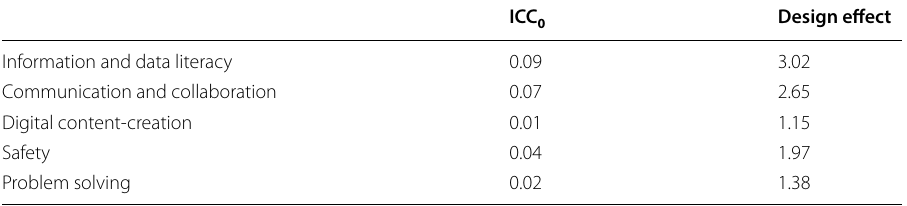
Table 3 Intra-class correlations (ICC) und design effect for dependent variables of digital